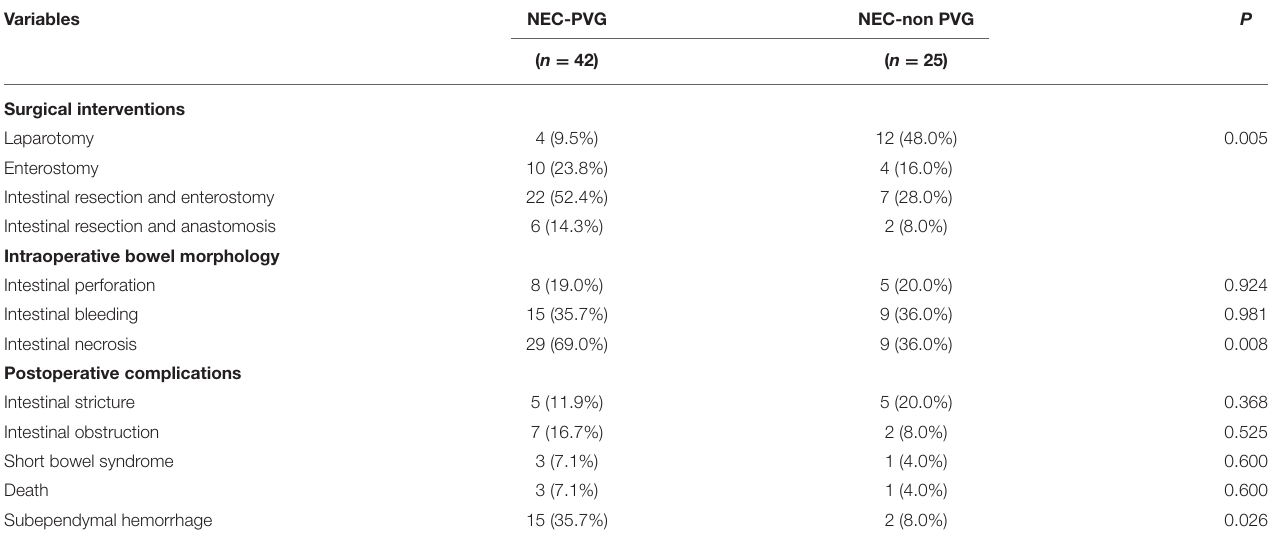
TABLE 4 | Surgical interventions and outcomes in neonates with surgery between both groups. Variables NEC-PVG